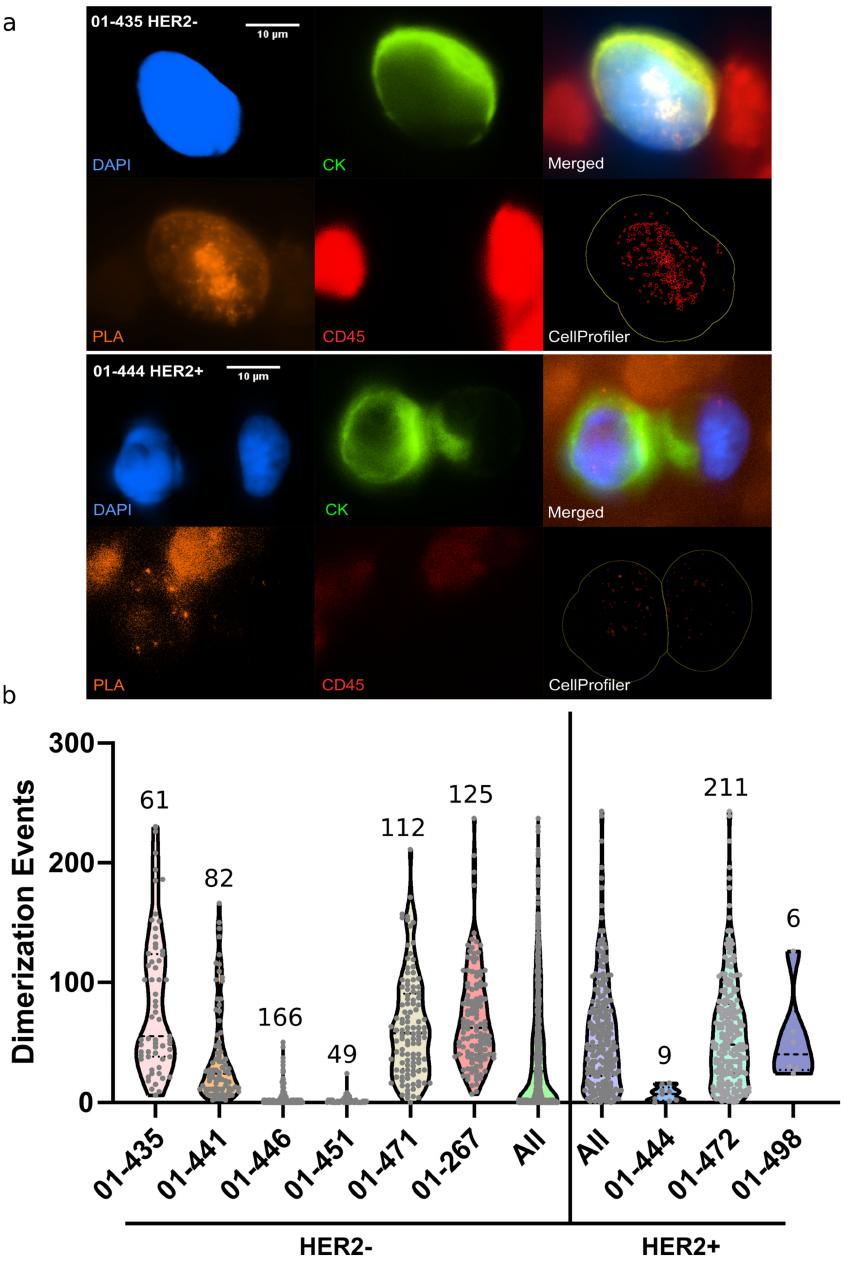
Figure 4. ( a ) Examples of CTCs detected from patient blood with MBC HER2 − or HER2+, using the Ephesia chip. CTCs were further subjected to PLA and immunostaining for CK, DAPI and CD45 detection. ( b ) Violin plots showing the distribution of HER2-HER3 PLA signal per cell (number of CTC detected indicated for each patient sample). Scale bar is 10 µ